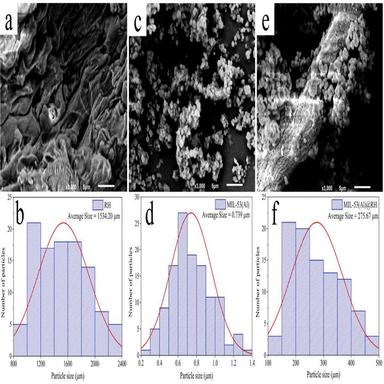
SEM images and particle size distribution: a,b)RH, c,d)MIL-53(Al), e,f) MIL-53(Al)@RH.